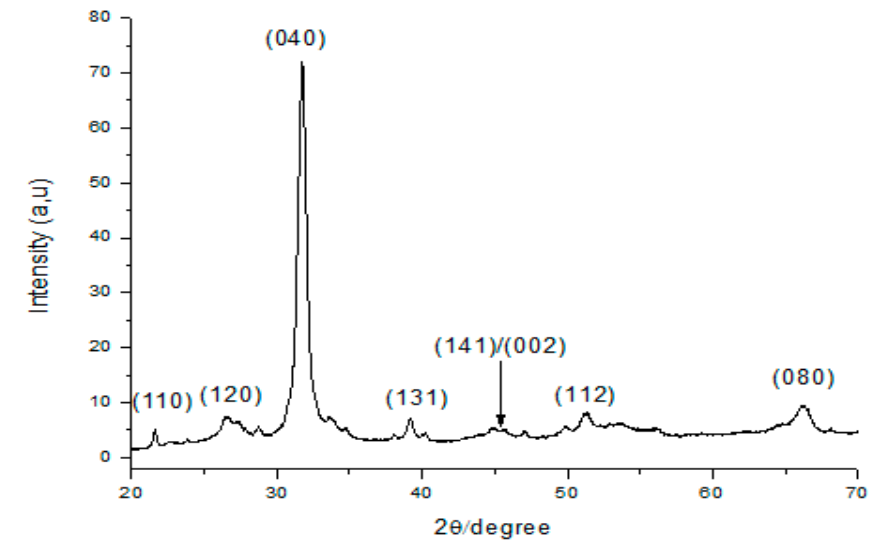
Figure 1. X-Ray diffraction patterns of SnS thin films deposited at various substrate